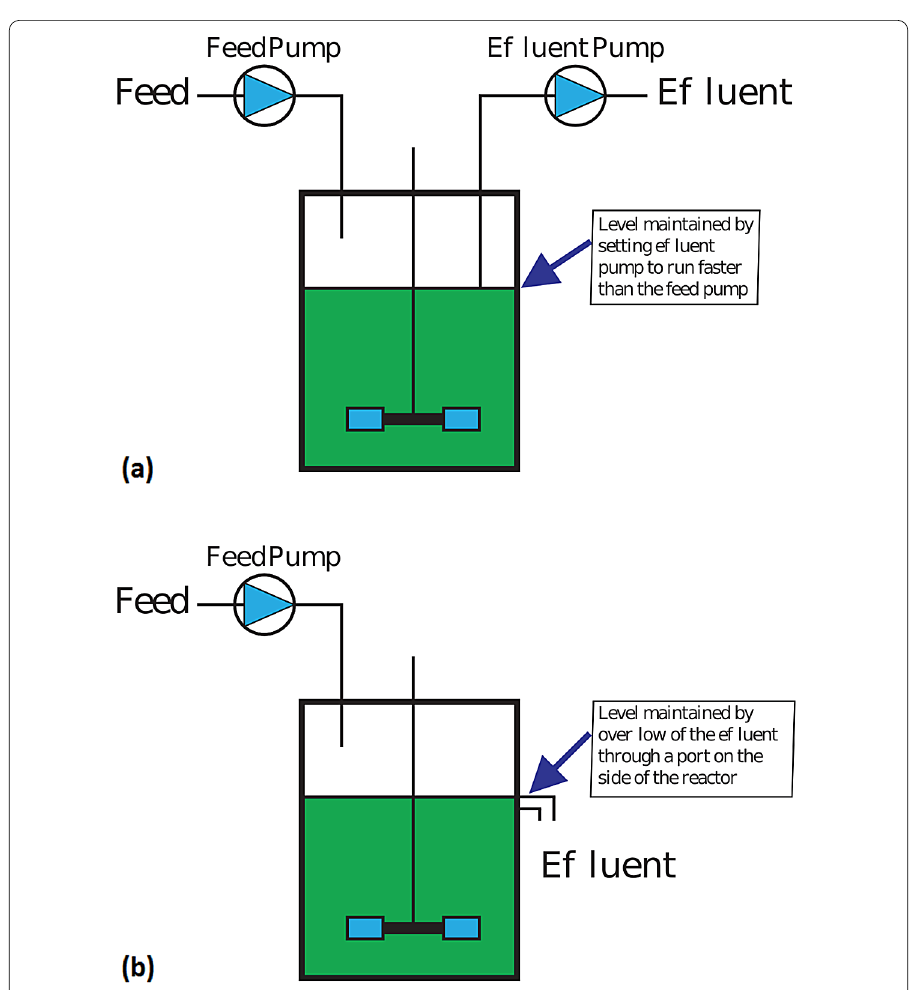
Figure 1 Two types of chemostat. (a) Type I chemostat. (b) Type II chemostat.